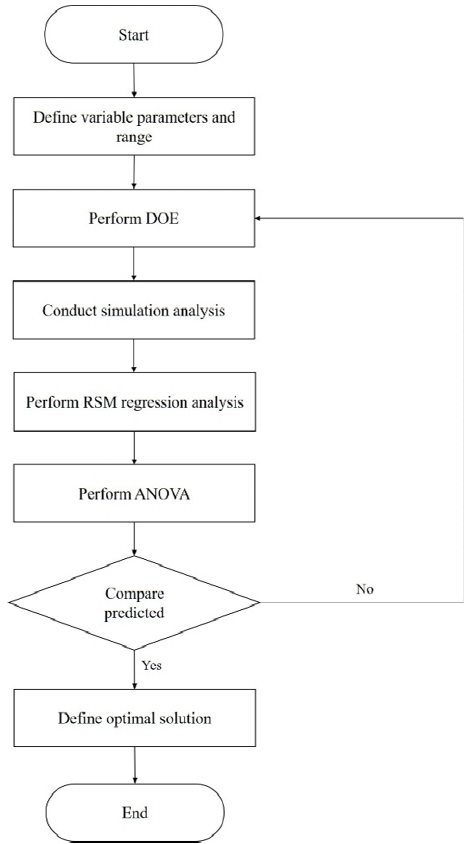
Figure 5. RSM flowchart applied by Hanid et al. [34], adapted from [34]. First, the variable parameters and their respective range were identified then, DOE was performed. The full factorial design with four added center points was selected, resulting in a total of 30 series. With the series generated by DOE, injection molding simulations took place in AMI software, and the warpage value was determined for each one. Having determined the warpage values, the RSM regression analysis took place resorting to the Design Expert 7.0 software (StatEase, Minneapollis, MN, USA) to determine the mathematical model that expresses the correlation between the independent parameters and the response, through regression analysis. Afterward, the results were assessed through analysis of variance (ANOVA), to identify the key parameters that influence the warpage. Aiming at the minimization of the latter, GSO and GA optimization were applied resorting to the second-order RSM mathematical model. The flowchart for the GSO and GA optimization process is presented in Figures 6 and 7, respectively. The simulation results were validated experimentally, where the GA predicted optimal process parameters, resulting in the highest warpage reduction.